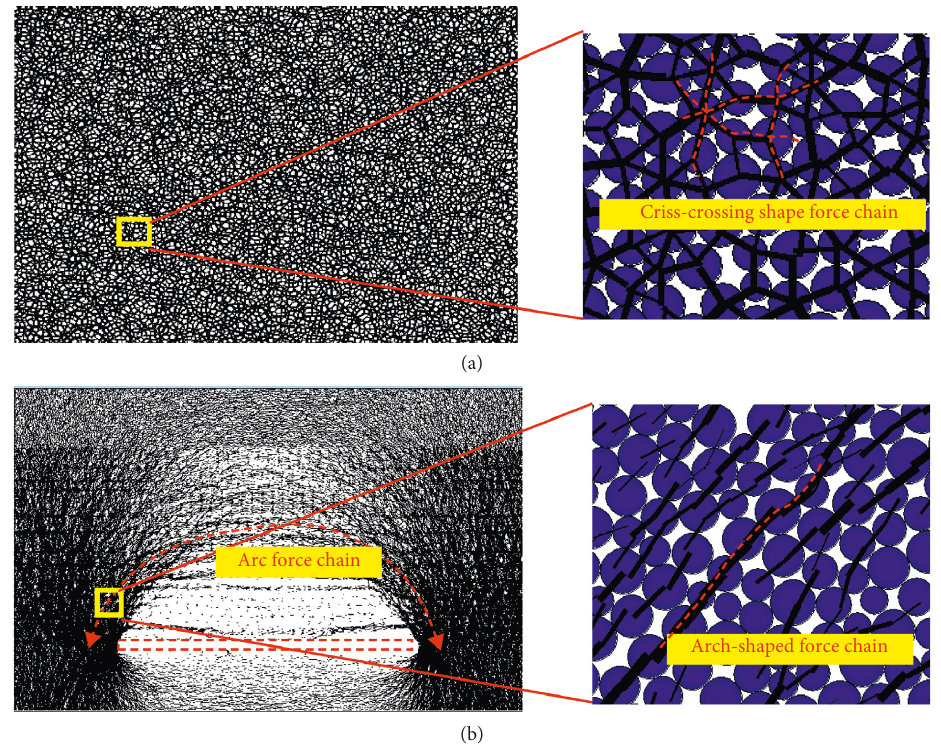
Figure 15: The distribution morphology of contact force chain: (a) unmined (criss-crossing shape force chain); (b) mined 100m (arch shape force chain).